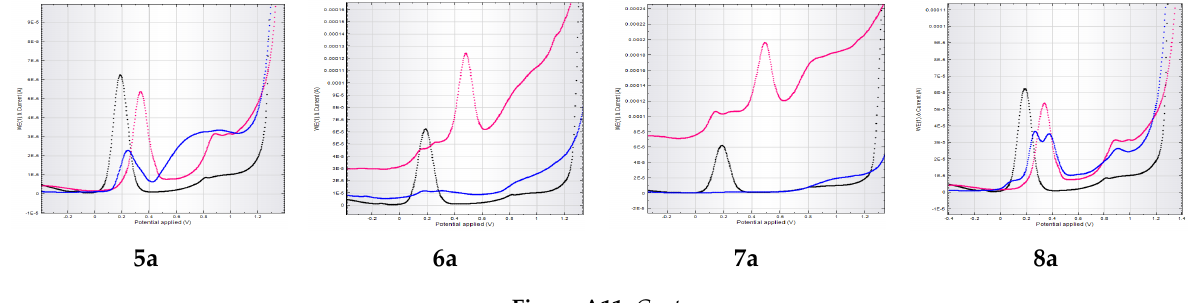
Figure A11. Cont